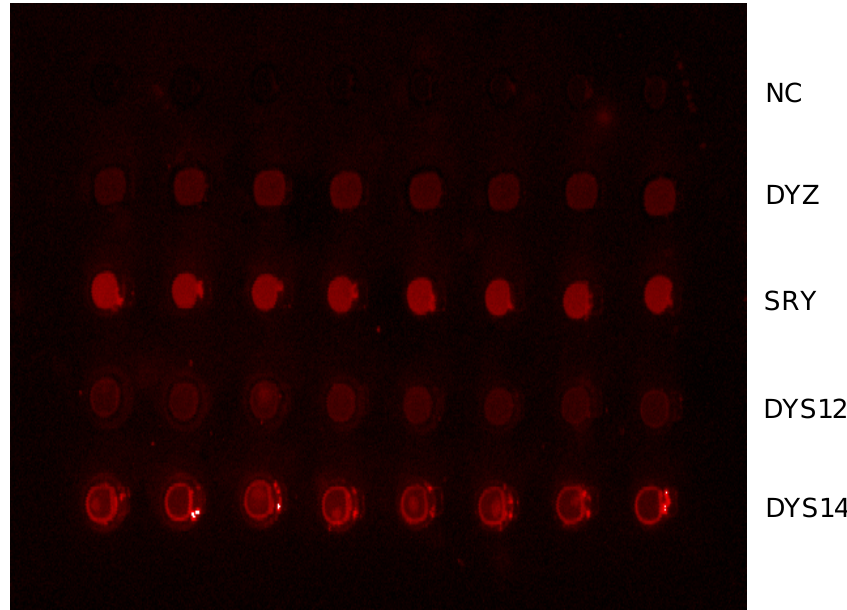
Figure 4. Results of fetal sex identification by the